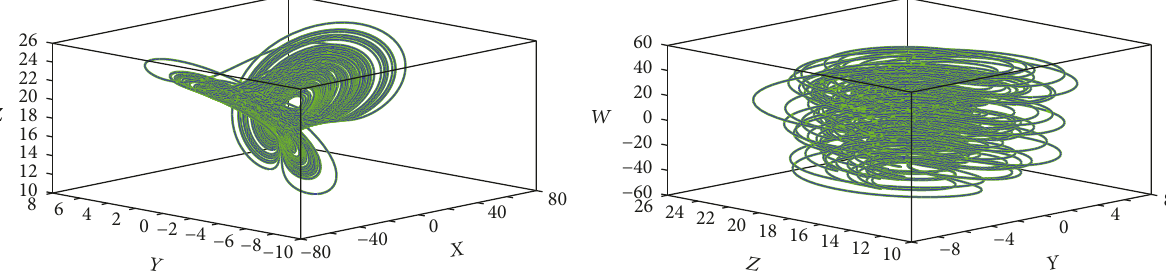
Figure 4: 3D phase portraits of the NCS 4 system.